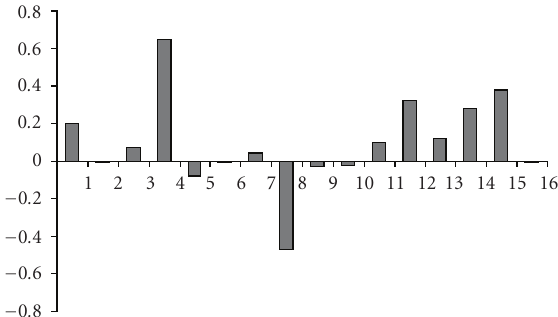
Figure 13: Standardized regression coe ffi cients for the defined performance